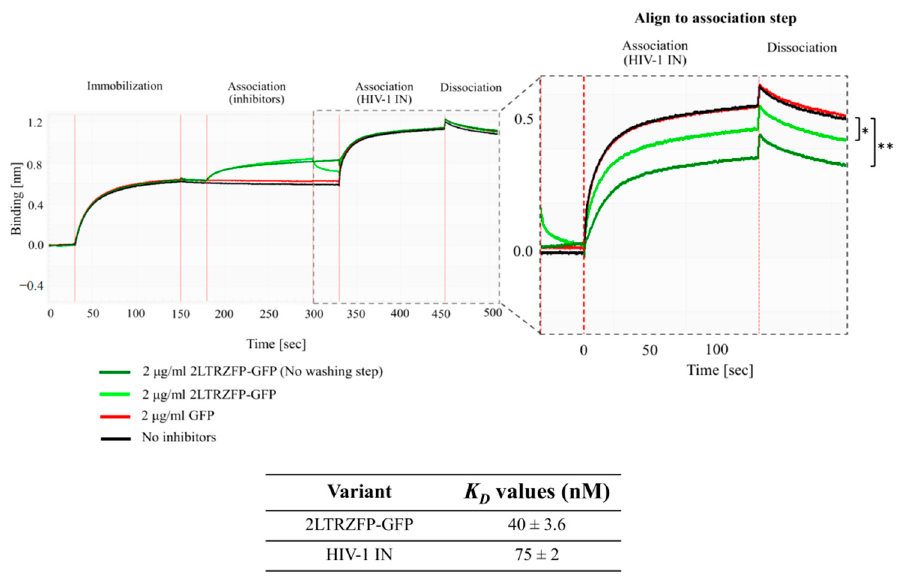
Figure 4. The inhibitory effect of 2LTRZFP-GFP on HIV-1 IN enzyme. Representative sensorgrams from triplicate exper- iments displaying the kinetics binding of HIV-1 IN towards biotinylated ds2LTR target in the condition that contained 2LTRZFP-GFP without washing step represented in dark green line. Whereas the bright green line was the competition with washing step. The GFP was used as an irrelevant control reperesented in red line. The K D values of 2LTRZFP-GFP and HIV-1 IN by BLItz TM system were shown in the table. The significant differences in binding signals and KD values were analyzed by Student’s t -test; ** p ≤ 0.01 and * p ≤ 0.05.